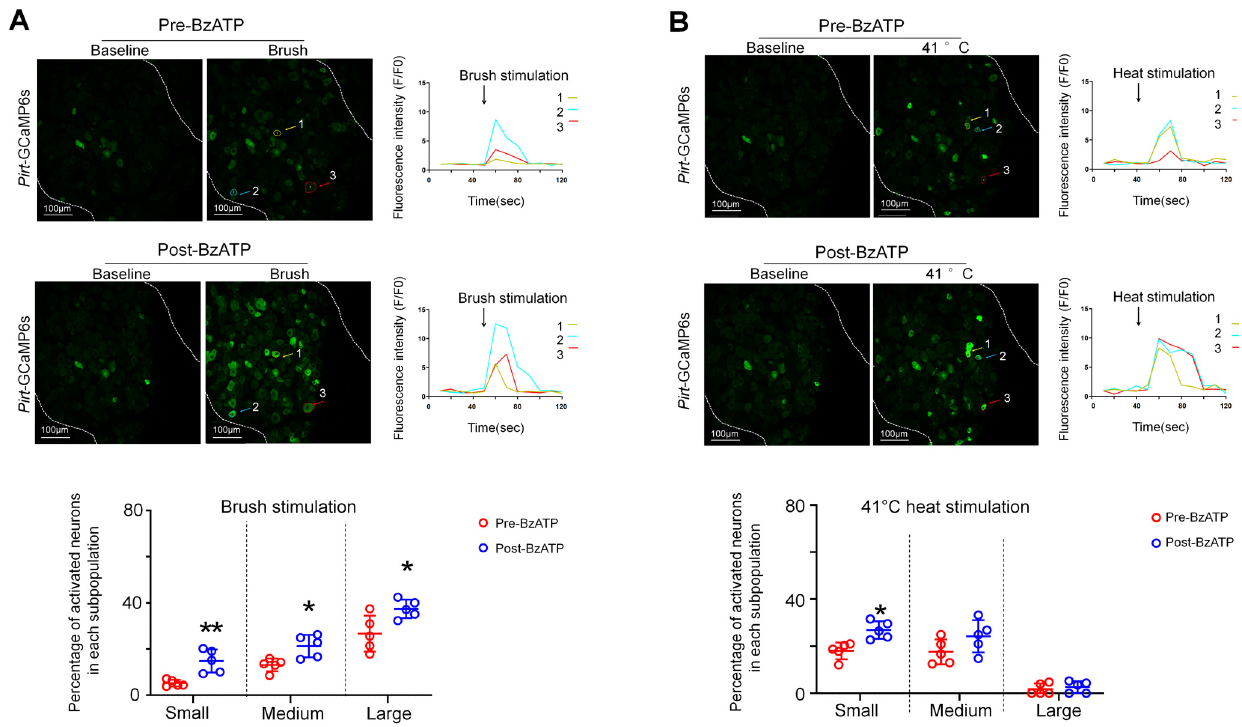
multiple comparisons test.